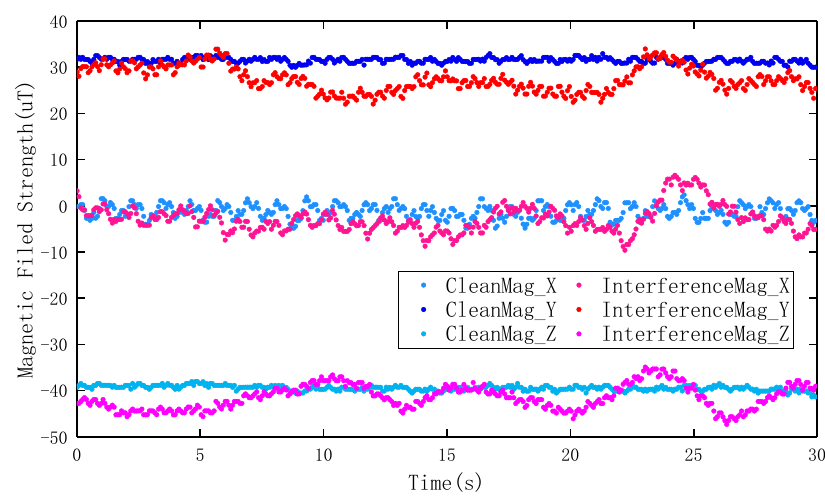
Figure 2. An example of the distribution of magnetic interference data in three axes. Micromachines 2020 , 11 , x